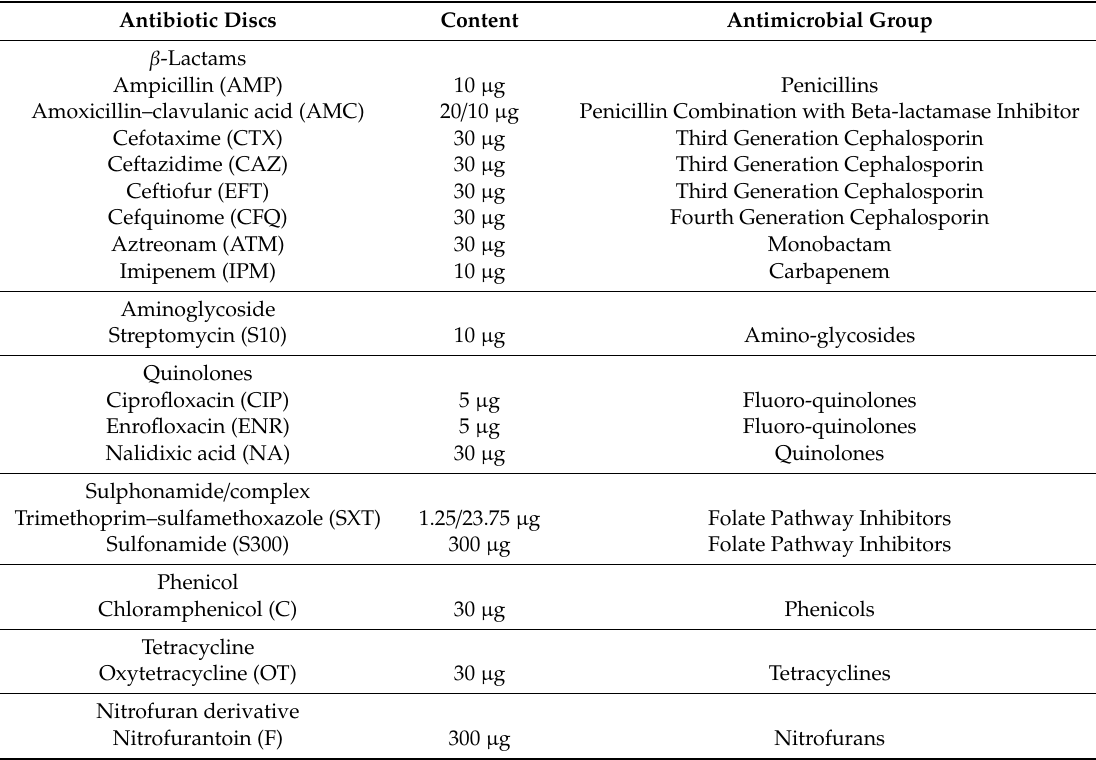
Table 3. Antibiotic assay discs, abbreviations, and amount of antibiotic contained in each